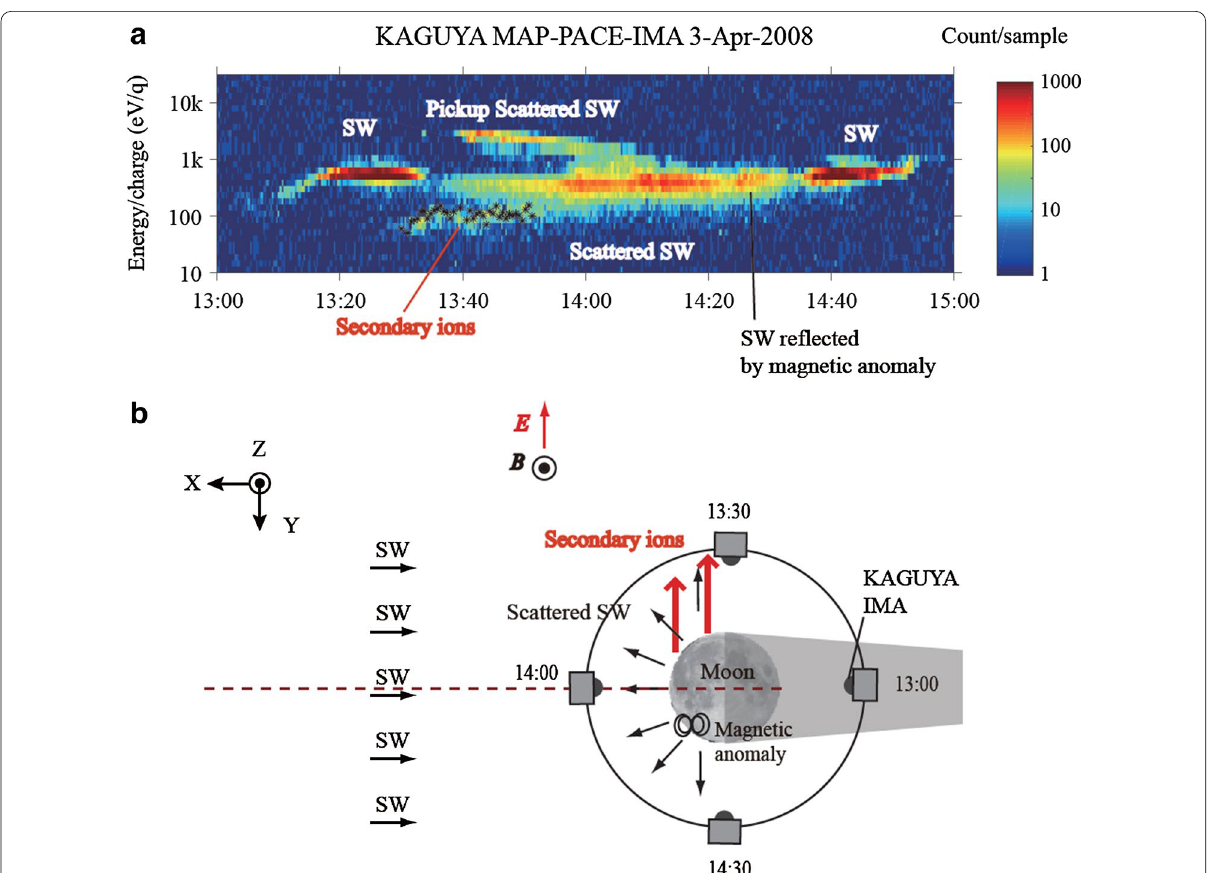
Fig. 6 Ion observation results around the Moon by the Kaguya spacecraft during 2 h on April 3, 2008. a Energy-time spectrograms of ions measured by the ion analyzer (IMA) between 13:00 and 15:00 universal time (UT). Black asterisks indicate electrical potential gaps, κ = L | E | , when the electric field is directed from the Moon to the spacecraft. b Ion observation configuration in the selenocentric solar ecliptic coordinates. The details of the observations are described in Saito et al.